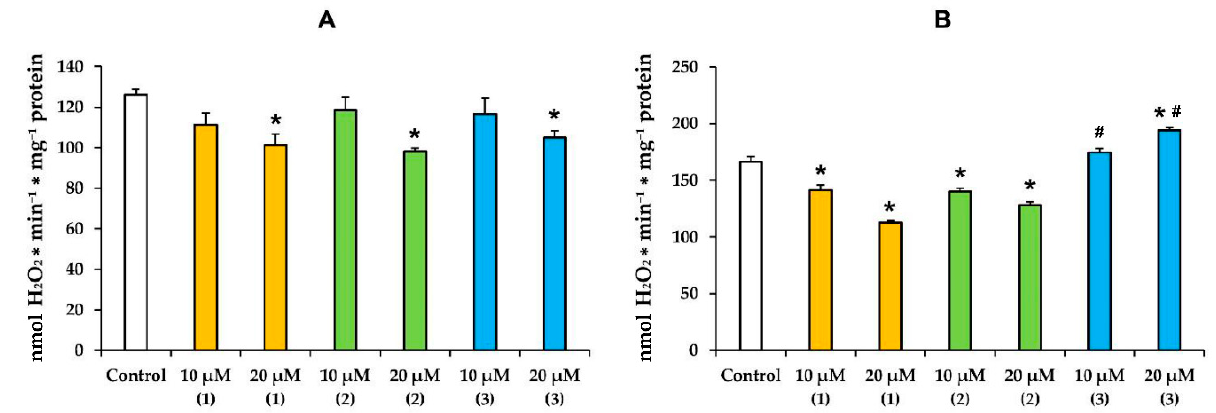
Figure 5. The rate of H 2 O 2 generation by rat liver mitochondria fueled by glutamate/malate ( A ) or succinate ( B ) in the presence of modified levopimaric acid diene adducts. The results are presented as means ± SEM ( n = 4). * p < 0.05 (versus control), # p < 0.05 (versus corresponding concentrations of compounds 1 and 2 ).